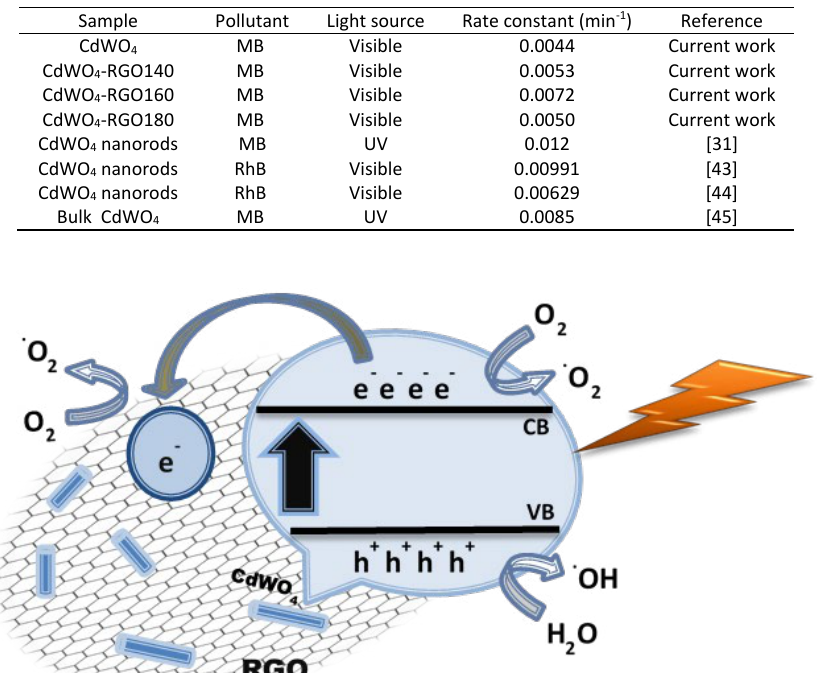
Table 2. Rate constants of photodegradation for current work samples as compared to other works.